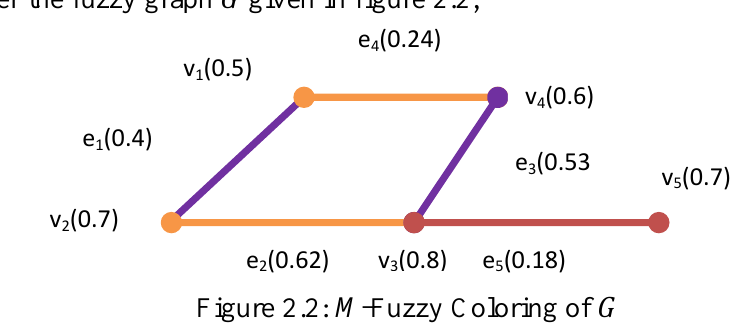
Figure 2.2: M- Fuzzy Coloring of 𝐺 Fig